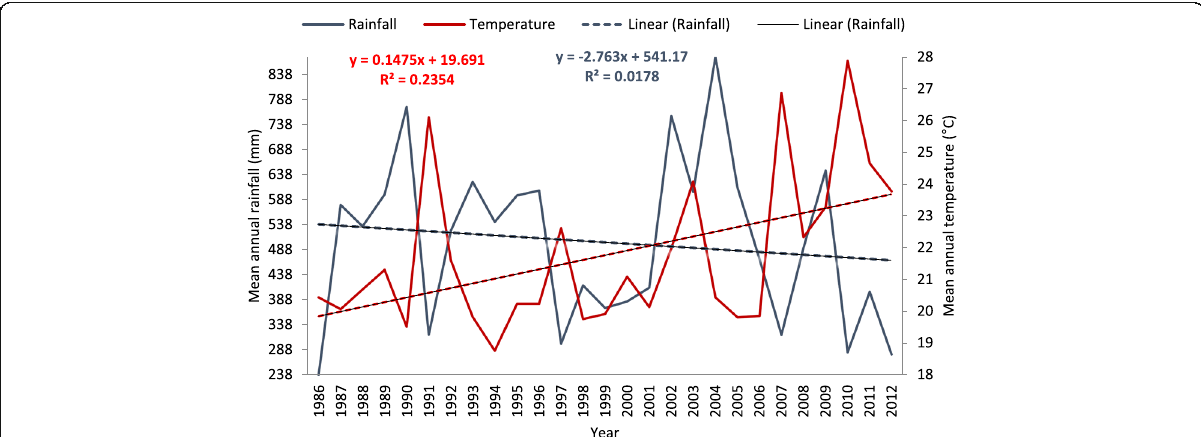
Fig. 1 Mean annual temperature and rainfall of Yabello district in Borana, southern Ethiopia (1986 – 2012) (equation in red color = temperature, equation in black color = rainfall). Source: Ethiopian National Meteorology Agency (2012)